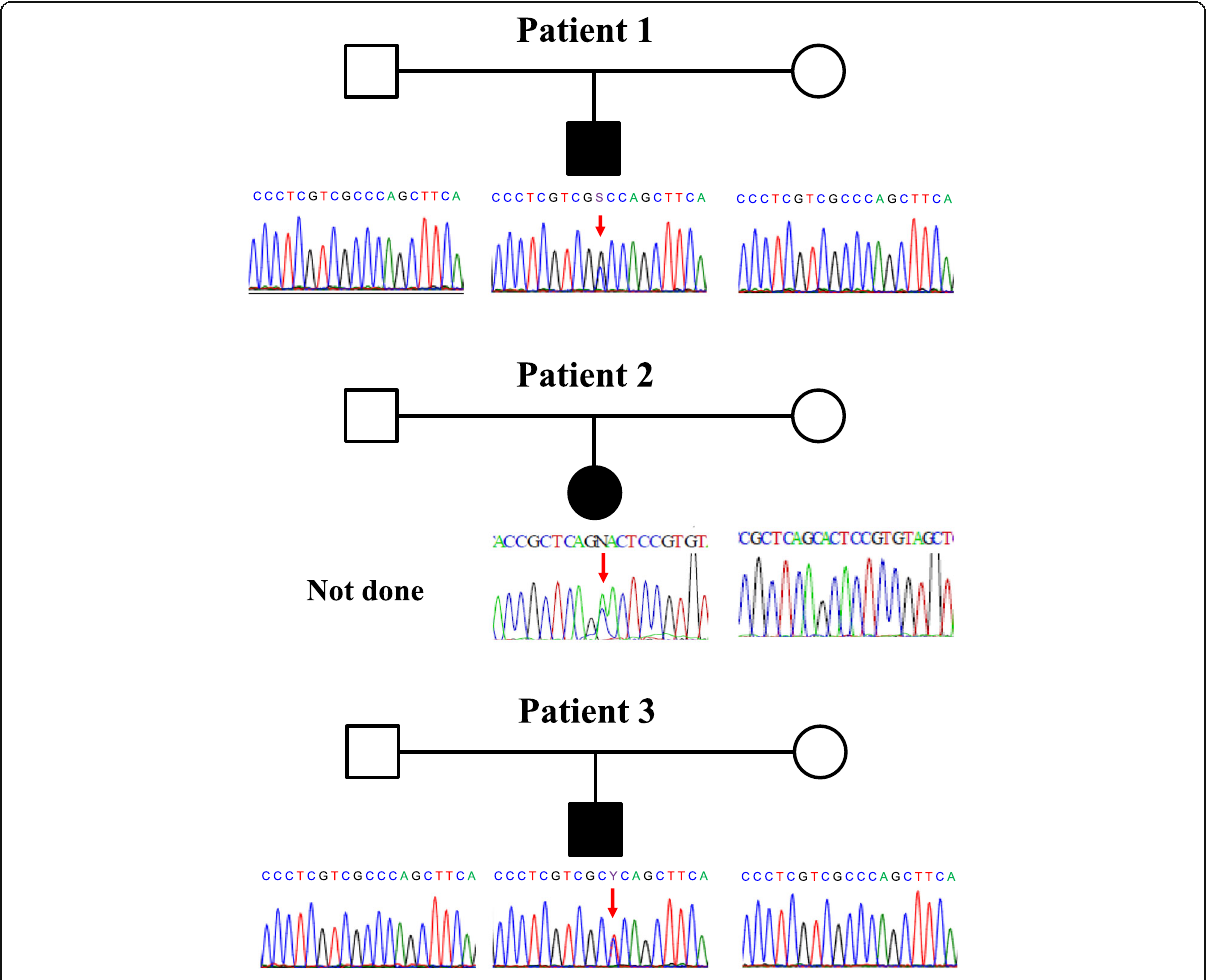
Fig. 3 Pedigrees and sequence chromatograms of the patients and their parents. Patients 1 and 3 carry a de novo heterozygous mutation of c.211C > G (p.Pro71Ala) and c.212C > T (p.Pro71Leu) in the MAFB gene, respectively. Patient 2 carries a heterozygous MAFB mutation, c.183C > A (p.Ser61Arg). Her mother does not carry the mutation and her father ’ s sample was